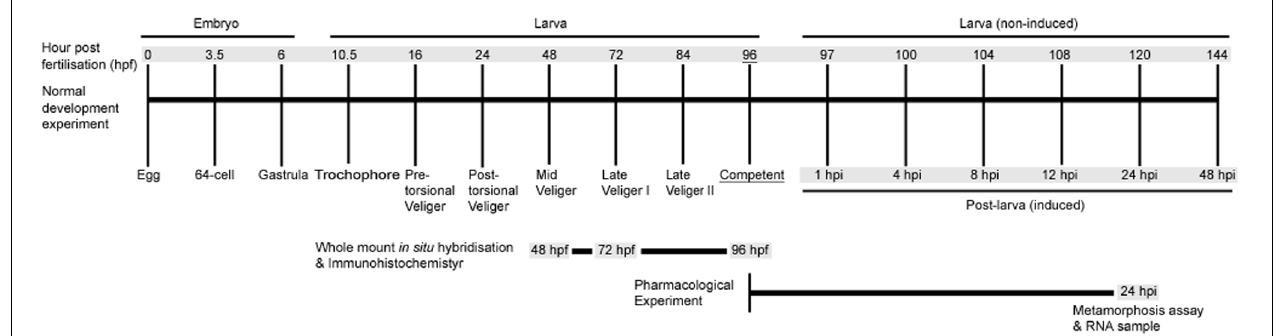
FIGURE 1 | A time course of Haliotis asinina development indicating experimental strategies employed in this study. Developmental stages are indicated by hours post fertilization (hpf) for embryonic and larval